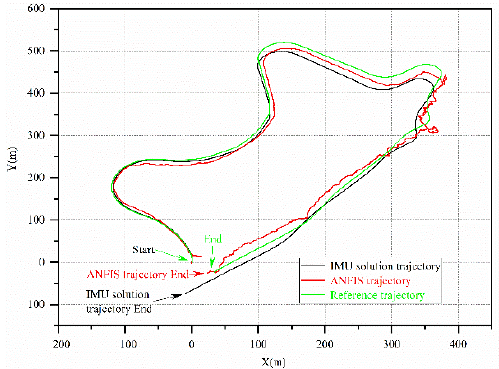
Figure 9. Comparison of INS solution trajectory, ANFIS trajectory and true trajectory.